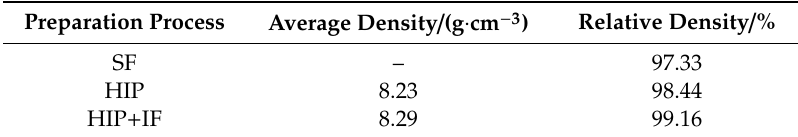
Table 3. Density and relative density of FGH100L alloys under di ff erent processes.